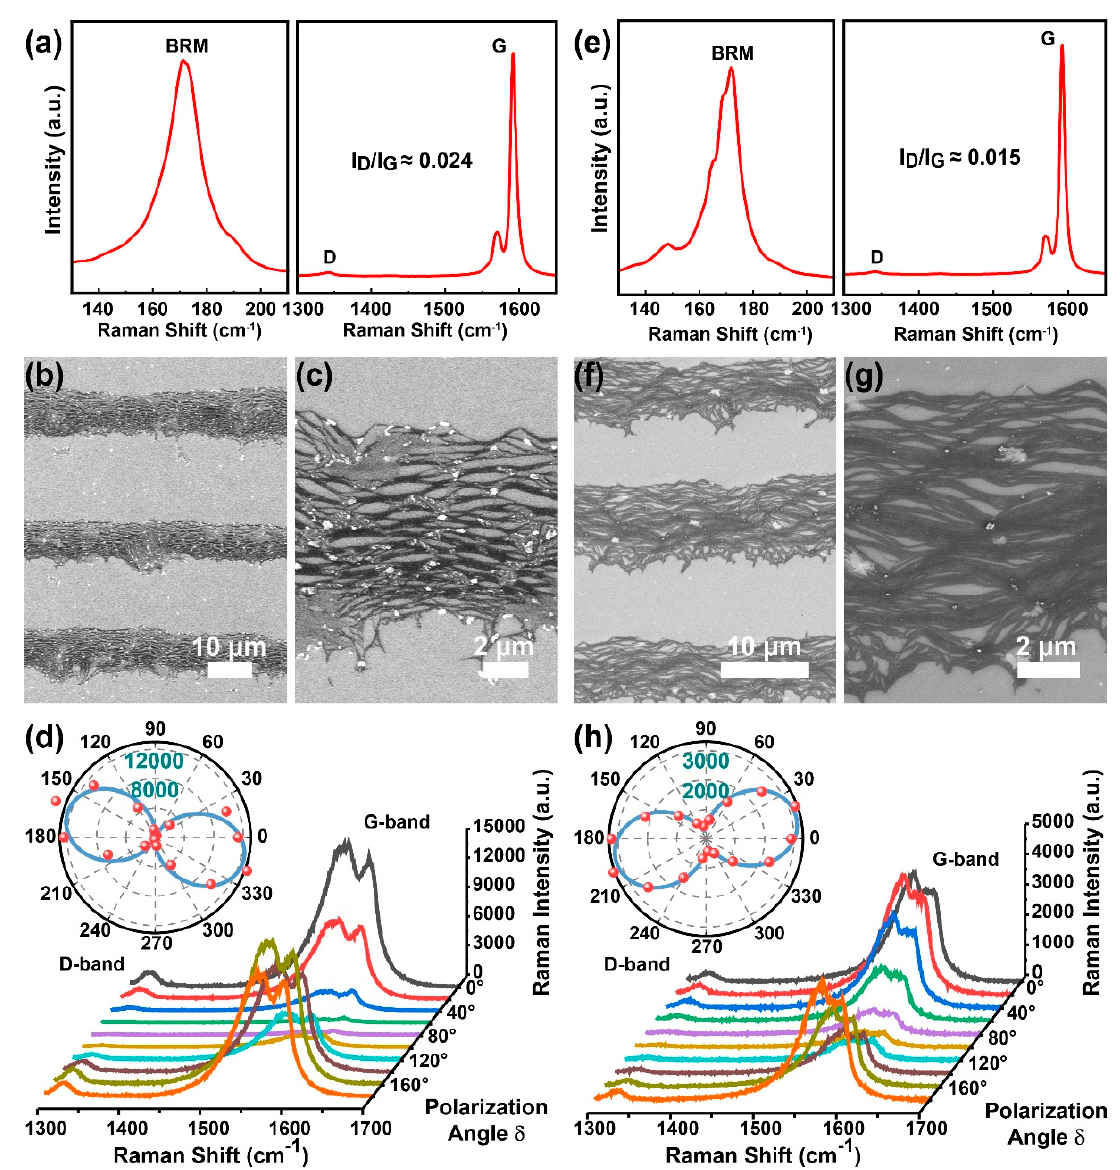
Figure 2. The corresponding Raman, SEM images, and polarized Raman patterns for SWCNT films prepared using SDS ( a – d ) and DOC ( e – h ) surface surfactants.